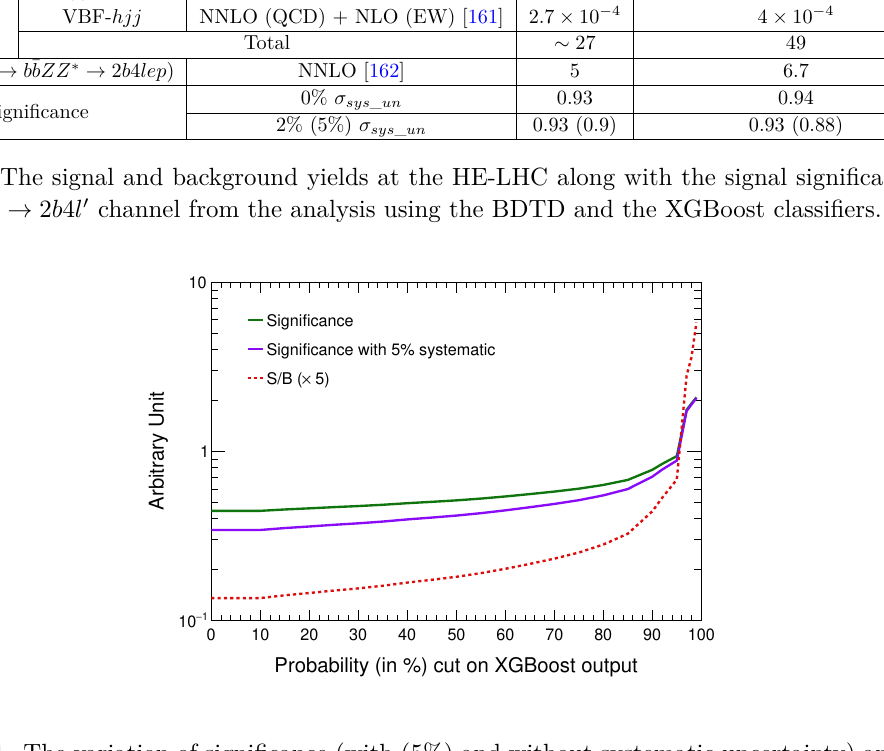
Figure 11 . The variation of significance (with ( 5% ) and without systematic uncertainty) and S/B is shown as a function of the probability cut on the XGBoost output for the b ¯ bZZ ∗ → b ¯ b 4 l 0